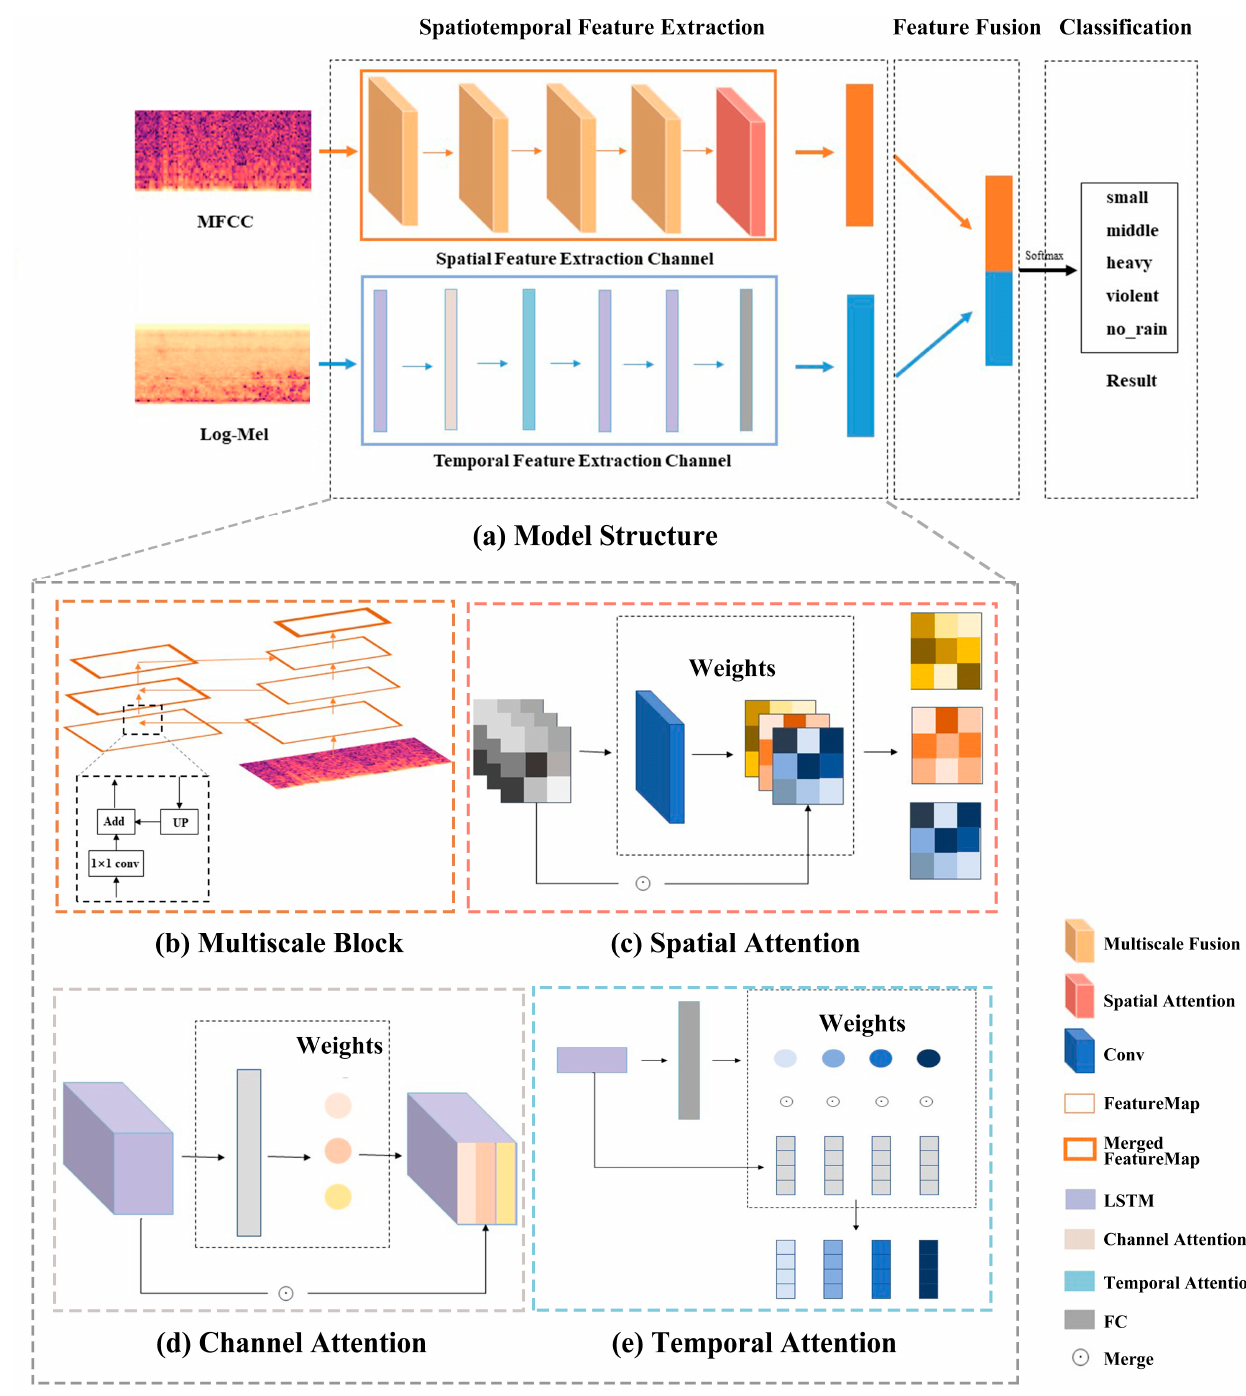
Figure 3. PNNAMMS